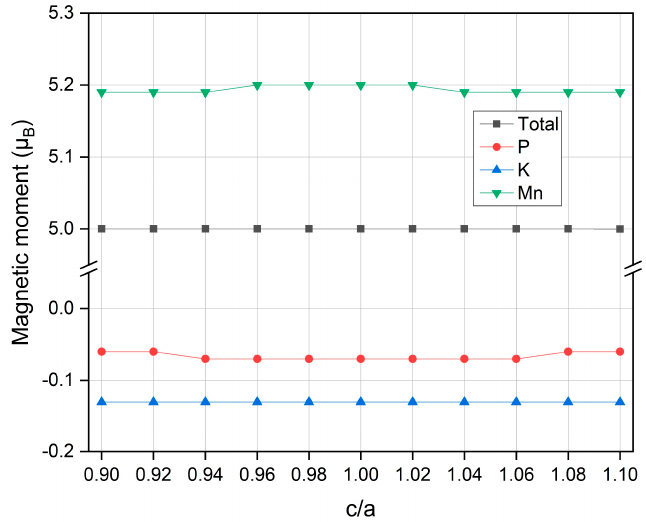
Figure 8. The calculated total and partial magnetic moments for the half Heusler compound MnPK under different tetragonal strain.